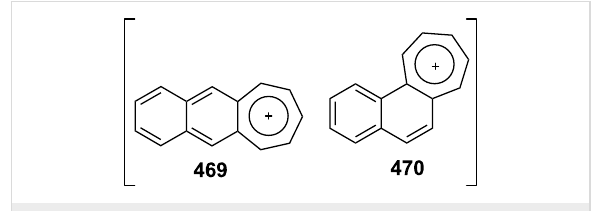
Figure 30: Structures of tropylium cations 469 and 470